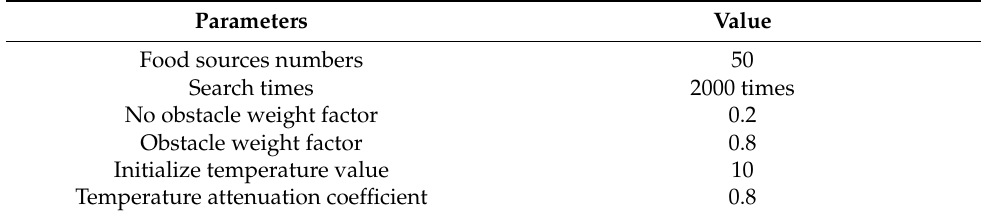
Table 1. The parameters of the artificial bee colony algorithm.